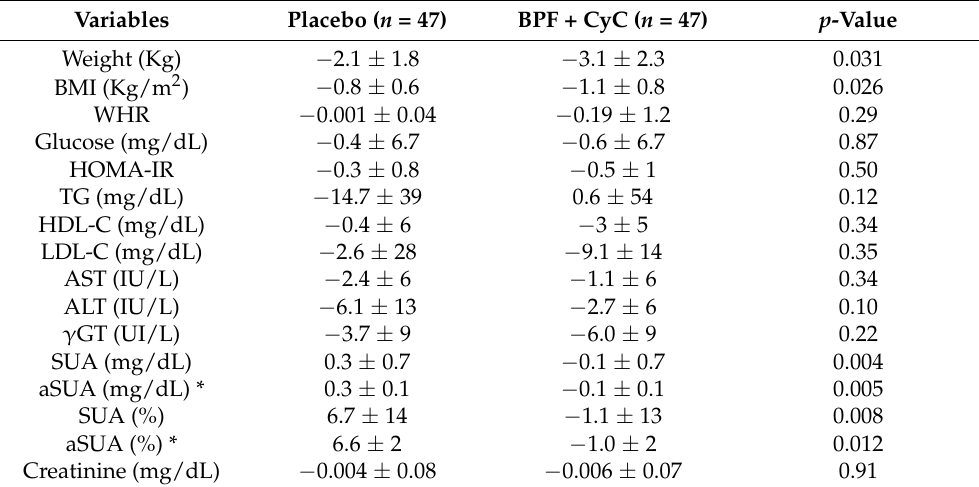
Table 2. Changes in clinical parameters at follow-up according to the treatments after 6 weeks.